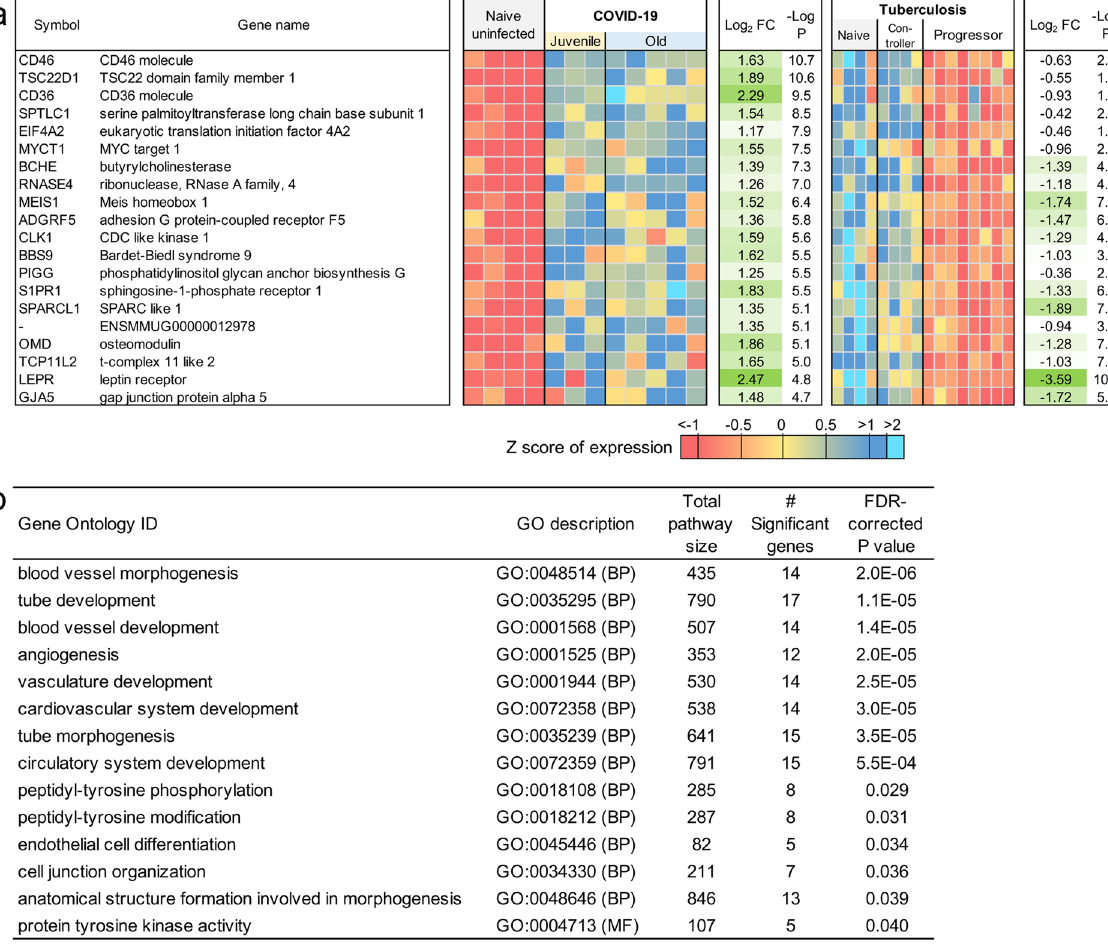
Fig. 10 Genes higher in expression during COVID-19 than TB are related to blood morphogenesis pathways. a The top 20 (of 76) most signi fi cantly upregulated genes in SARS-CoV-2-infected compared to Mtb -infected macaques. Expression values are visualized by Z scores of normalized expression data (FPKM) per sample, and Log 2 fold change and -Log P values are from the DESeq2 output. Genes are sorted by P value. b Signi fi cant Gene Ontology pathway enrichment among the 76